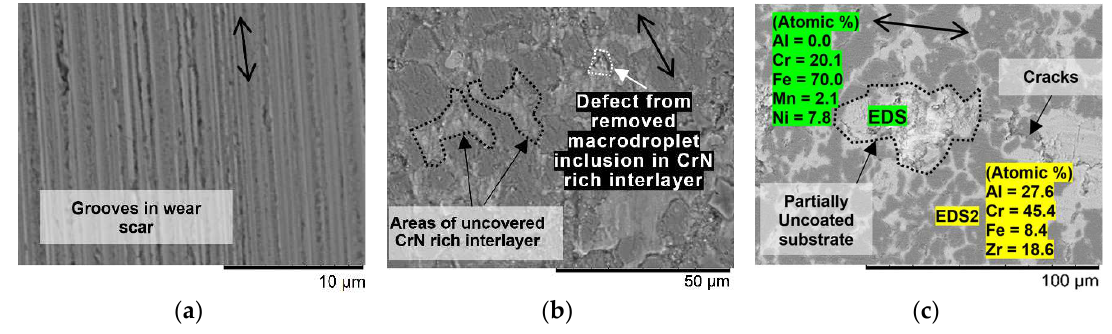
Figure 7. SEM micrographs show grooves inside wear scars after short (2 h) tribo-corrosion test with AISI 316L ( a ), and defects after extended (12 h) tribo-corrosion tests with AlCrN coated AISI 316L specimens under 1 kg ( b ), and 3 kg loads ( c ). Double arrowed line shows reciprocating sliding direction; elemental analysis was done with EDS inside and close to the marked area.